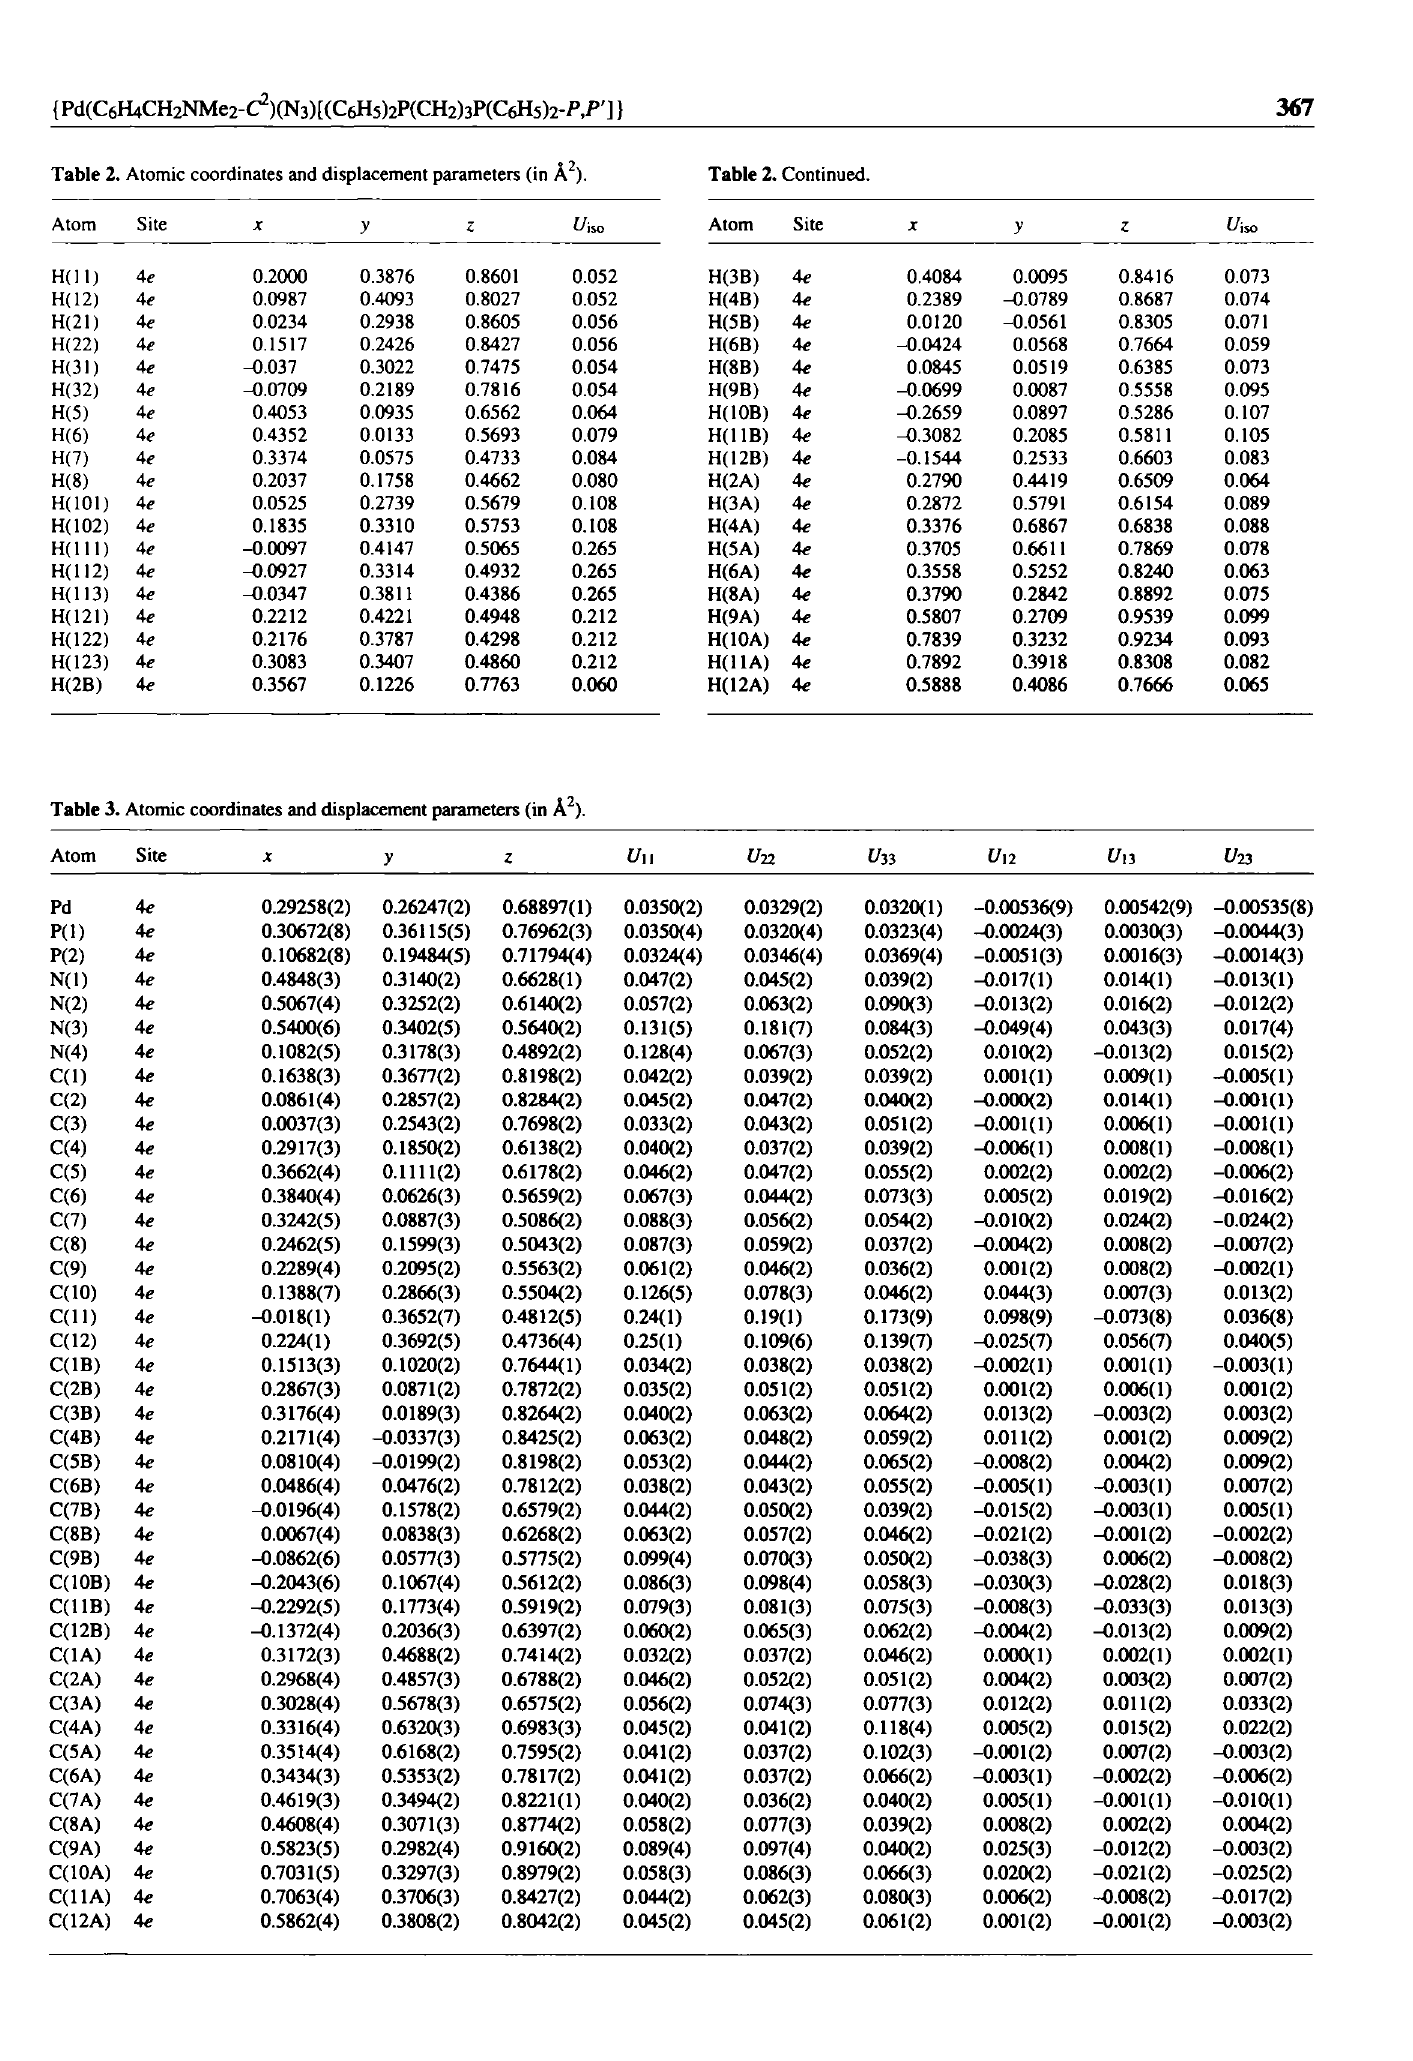
Table 3. Atomic coordinates and displacement parameters (in Â 2